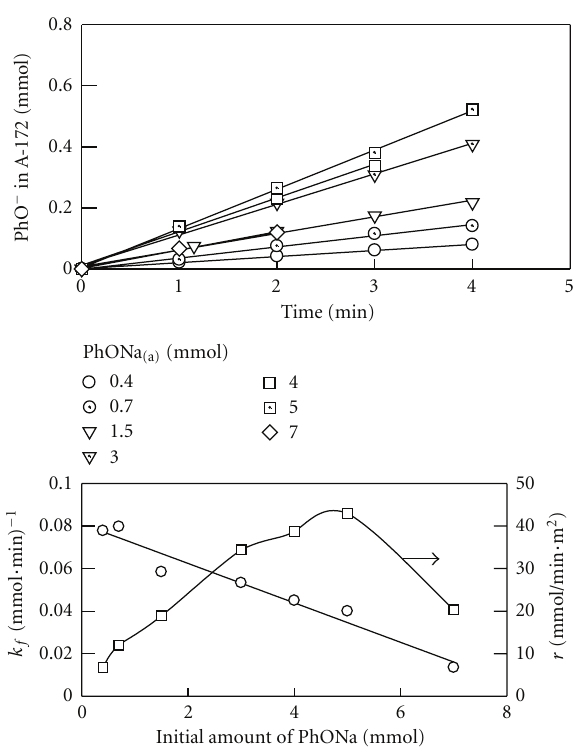
Figure 7: Contact angles of dry A172 membrane with di ff erent concentrations of phenol and molar ratios of allylbromide to phenol.